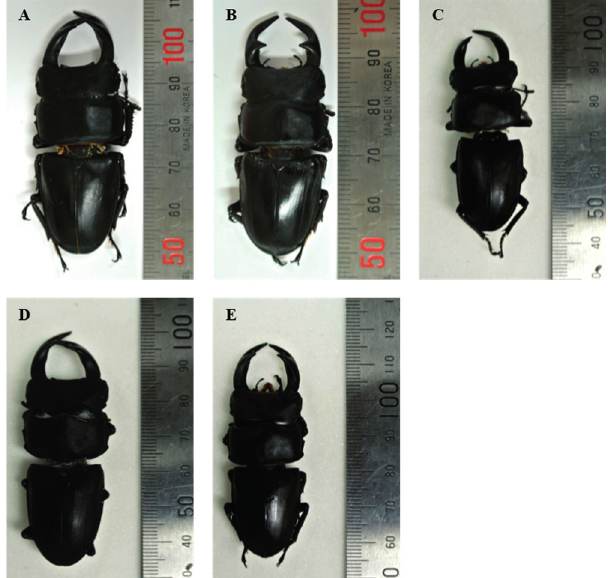
Figure 2. Comparsion of body length on each regional population of Dorcus hopei . ( A , Shichuan population, about 58 mm; B , Guangxi population, about 50 mm; C , Wanju population, about 58 mm; D , Nonsan population (cross-breed), about 70 mm; E , Nirasaki population, about 60 mm).